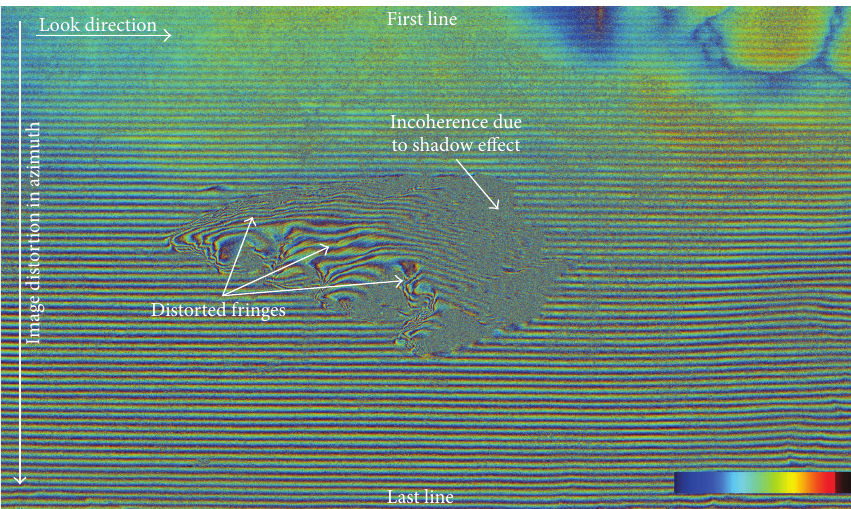
Figure 9: TerraSAR-X image pair (Uluru) with default frequency shift in DORIS. The image is not corrected and gets distorted towards the last line.